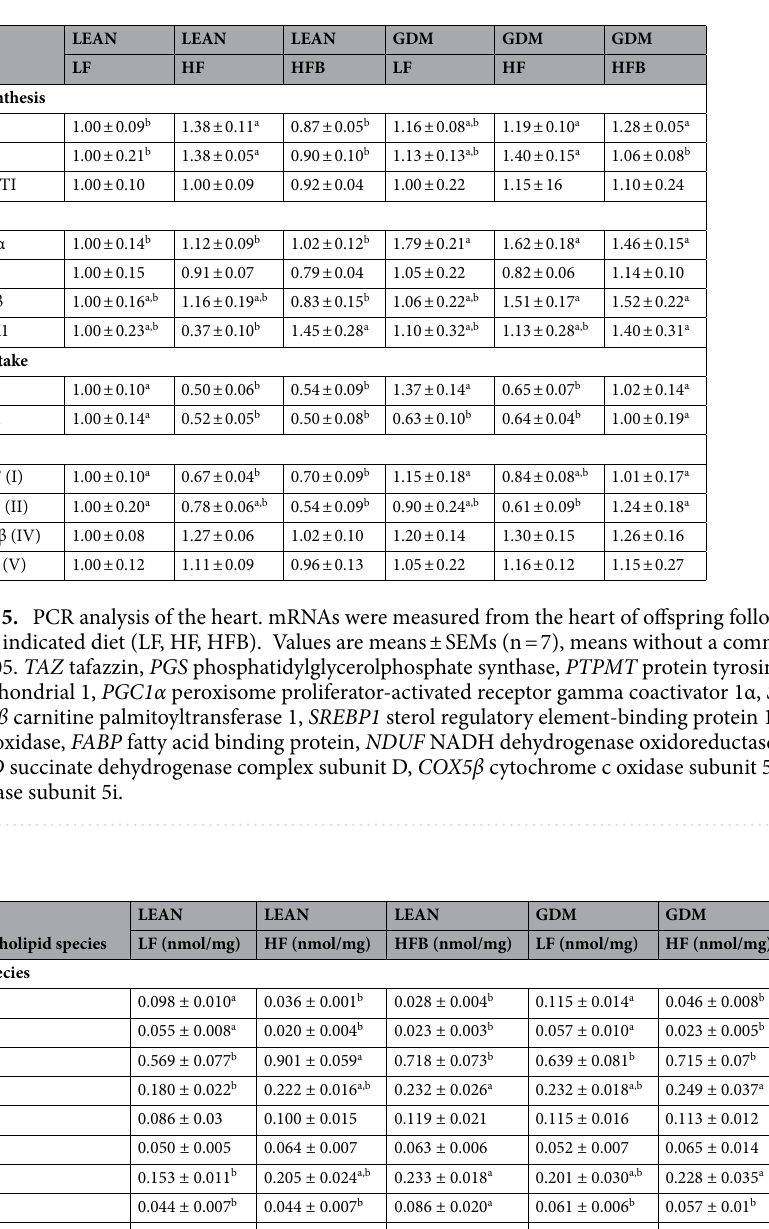
Table 6. Quantitation of phospholipids and CL molecular species in the heart. Quantitation of phospholipids and molecular species of CL from the heart of offspring following 12-weeks of the indicated diet (LF, HF, HFB). Values are means ± SEMs (n = 8), means without a common letter differ, p < 0.05.